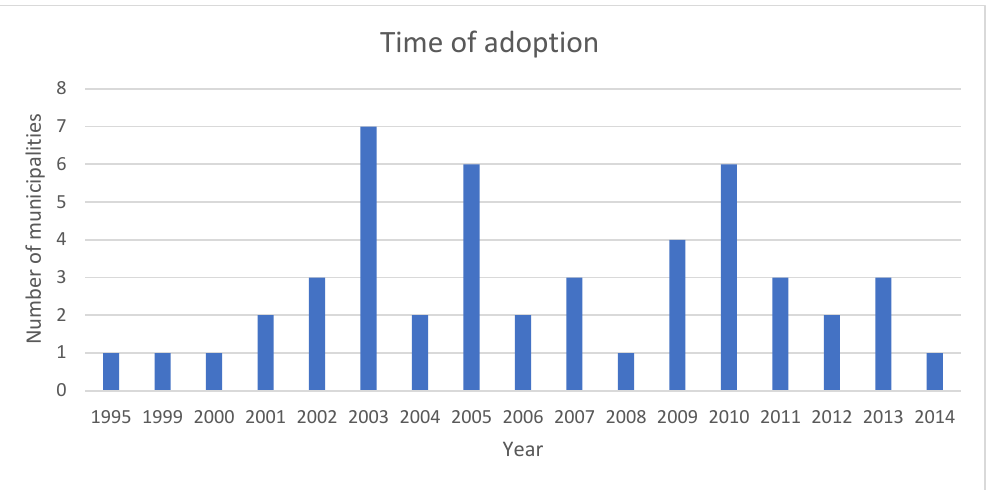
Figure 1. Time of adoption (N = 48).